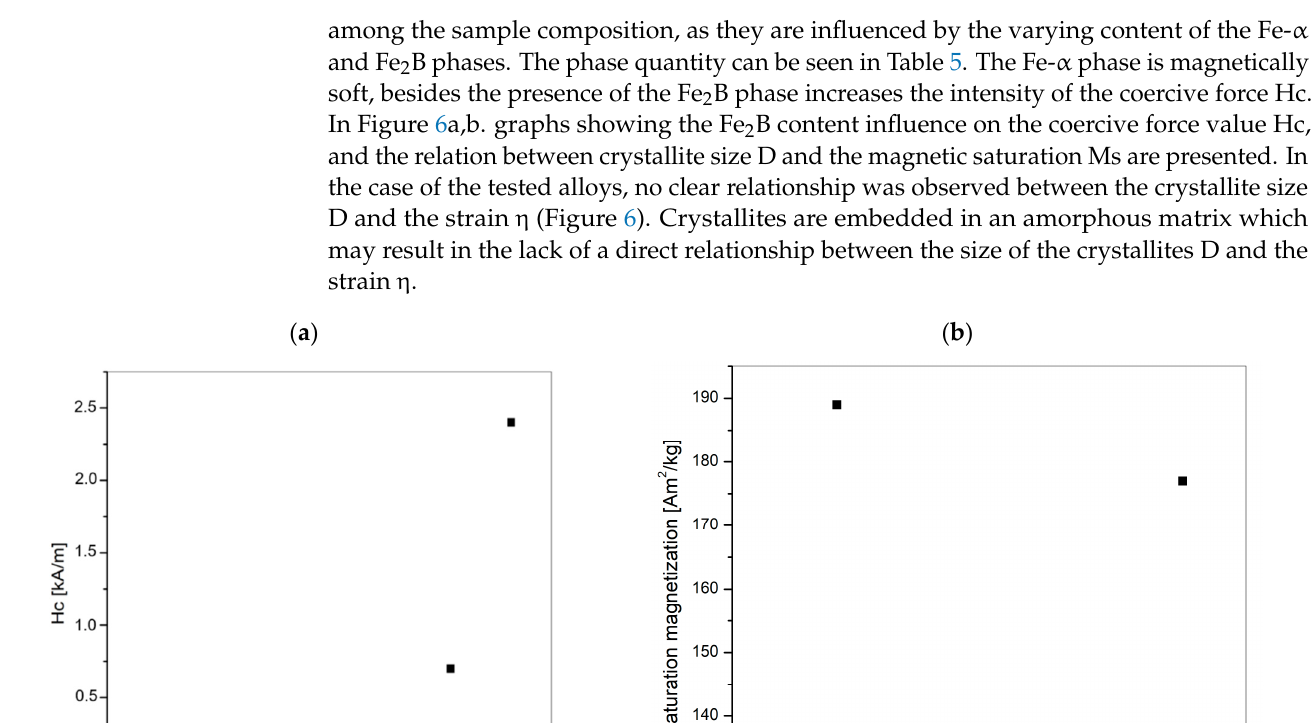
Figure 6. Graphs showing ( a ) the Fe 2 B content influence on the coercive force value Hc, ( b ) the relation between crystallite size D and the magnetic saturation Ms.